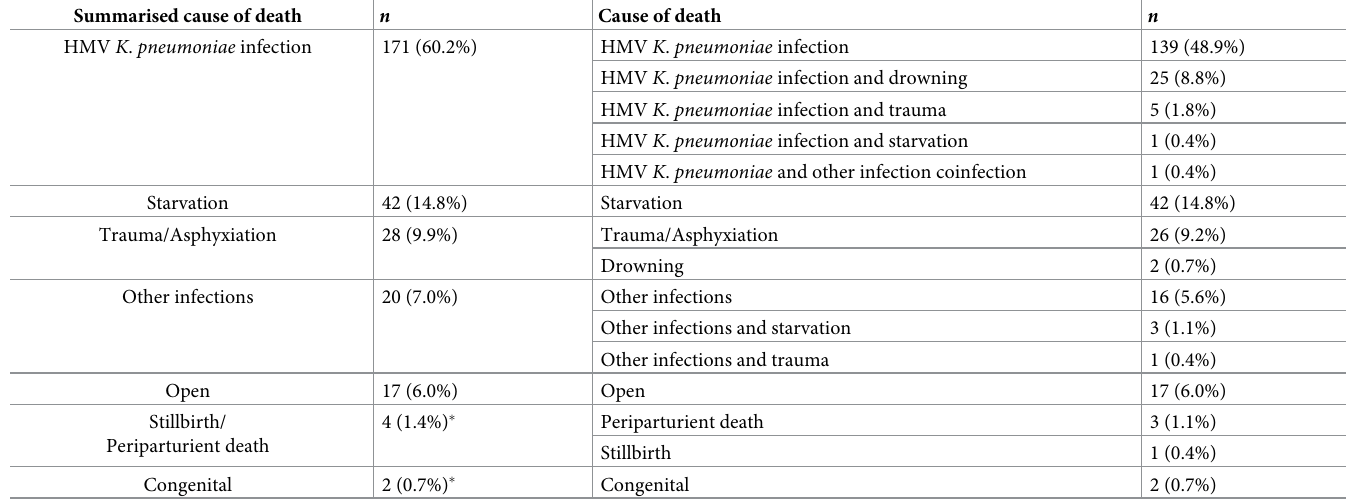
2 (0.7%) � 2 (0.7%) � This value is underestimated as three out of five seasons did not include the dates of peak pupping, therefore stillbirths, periparturient deaths and fatal congenital defects could not have been observed if they occurred.